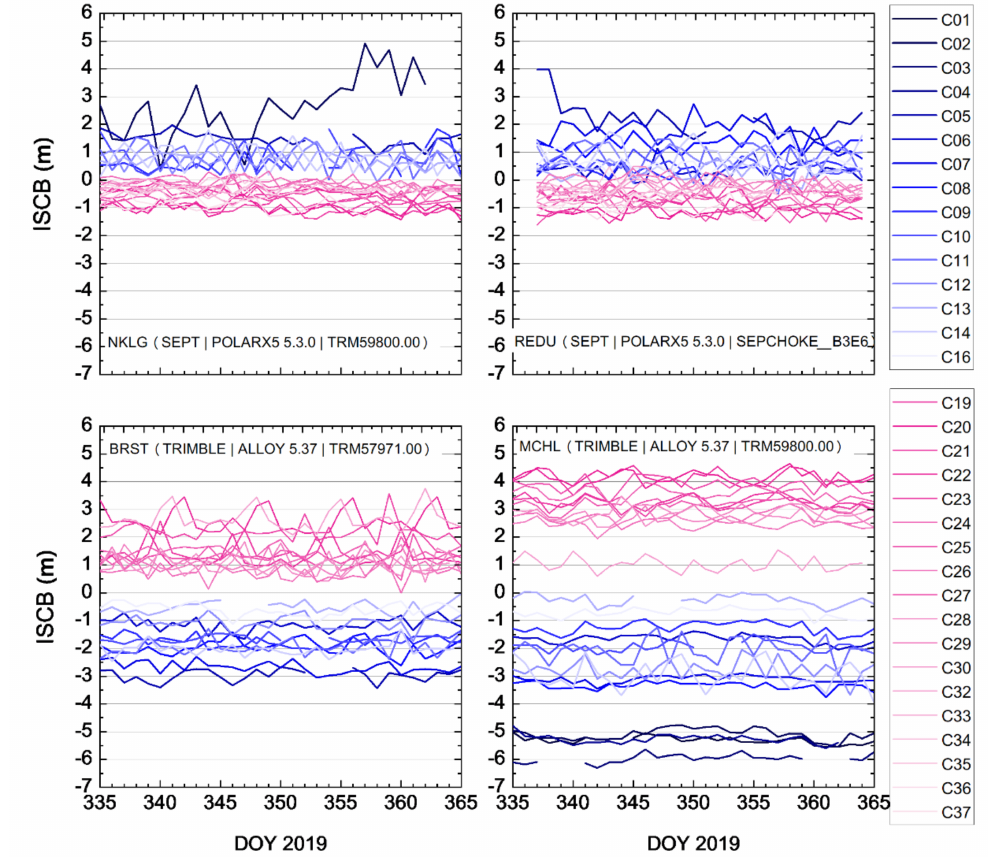
Figure 3. BDS, 2 and BDS, 3 ISCB clustering of Septentrio (NKLG and REDU) and Trimble (BRST and